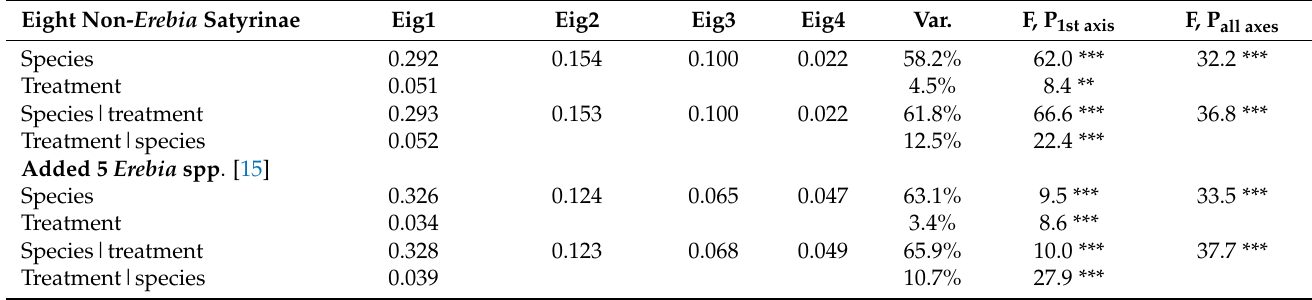
Table 2. Results of canonical correspondence analyses testing the effects of species and treatment (Autumn vs. Winter) on the composition of sugar and polyol profiles of the Satyrinae species assayed in this study, and results obtained after merging the data with five Erebia species studied from [15]. Eig1–Eig4 are values of canonical eigenvalues, Var. is variation in the data explained by the ordination model, while F and p values refer to results of Monte Carlo permutation tests.